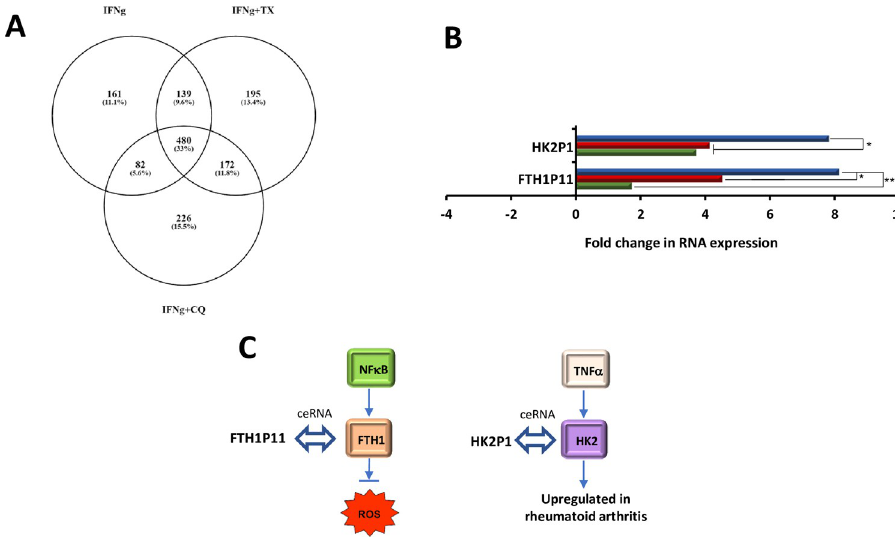
Fig 5. Pseudogenes involved in MIAMI cells’ response to inflammation. A: Venn diagram showing numbers and percentages of unique and overlapping differentially regulated pseudogenes; B: Fold changes in selected pseudogenes; C: Putative functions of selected RNAs; green bar IFN γ , red bar IFN γ +TX, blue bar IFN γ +CQ. Values that are significantly different are indicated by bars and asterisks as follows: � , P � 0.05; �� , P � 0.01.